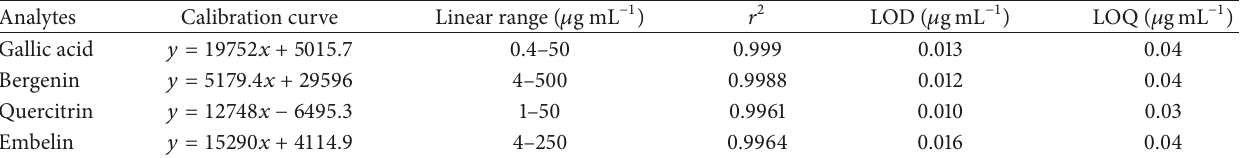
Table 1: Calibration curve, linear range, LOD, and LOQ of the investigated analytes.